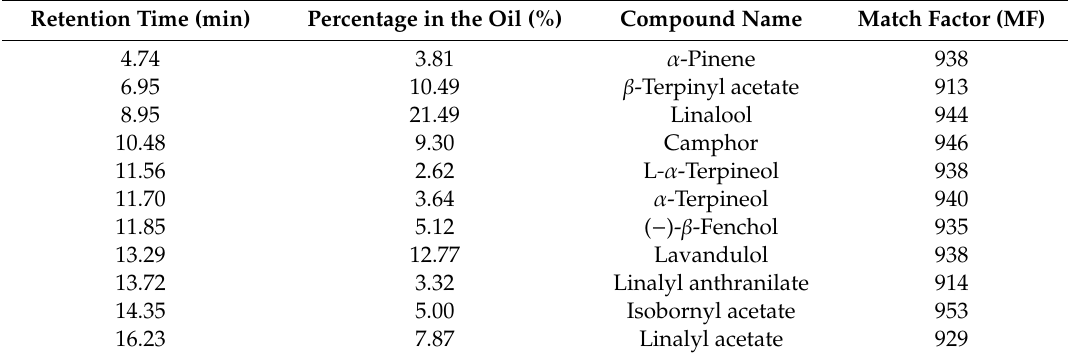
Table 1. Gas chromatography–mass spectrometry (GC-MS) results for the extract of Lavandula latifolia .